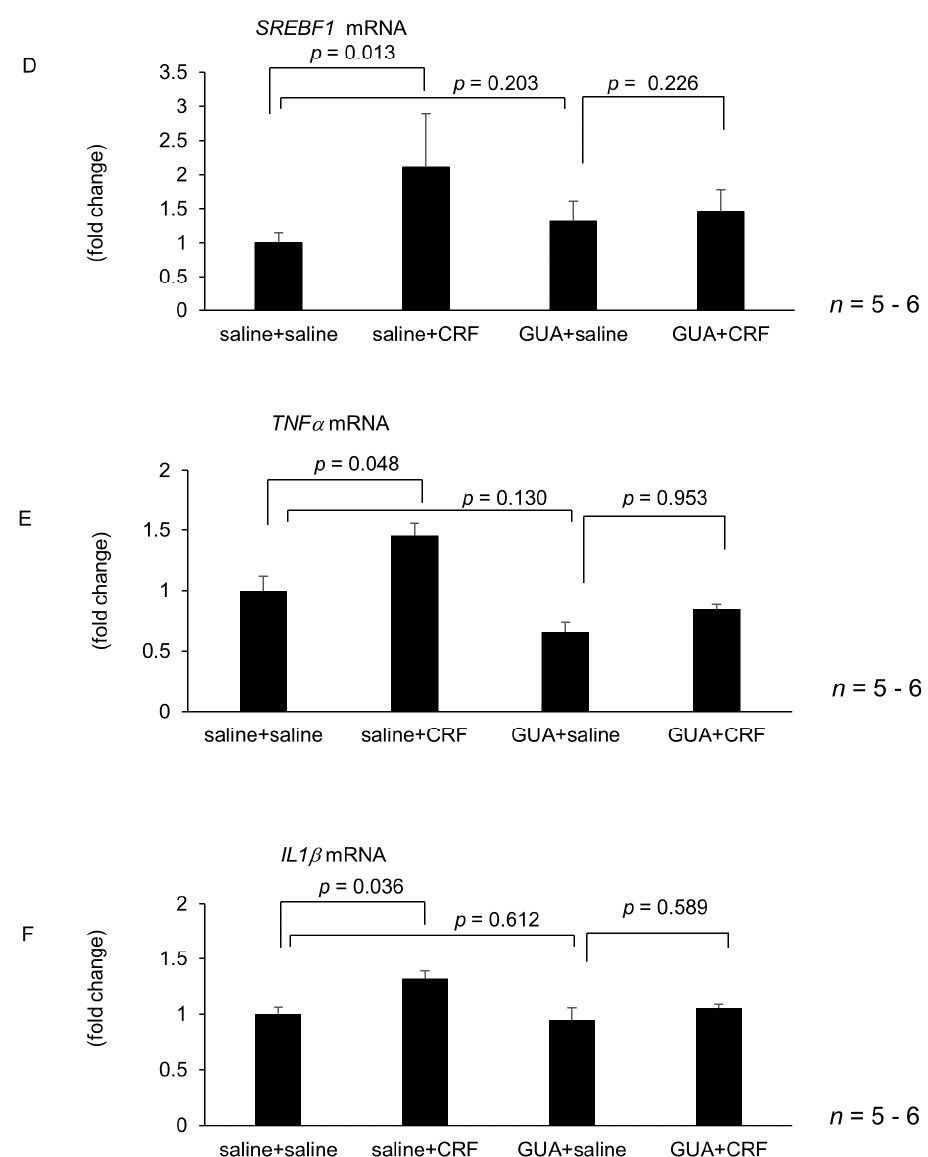
Figure 4. Effect of atropine (ATR) or guanethidine (GUA) on intracisternal CRF-mediated hepatic gene expression. The number of each group in rats was six. Hepatic lipid metabolism and inflammation-related gene expression 6 h after intracisternal CRF administration. Relative mRNA expressions of SREBF1 , TNF α , and IL1 β mediated by ATR ( A – C ) were evaluated and compared with respective saline control. Relative mRNA expressions of SREBF1 , TNF α , and IL1 β mediated by GUA ( D – F ) were evaluated and compared with respective saline control. Statistical analysis was performed using ANOVA, and data are expressed as means ± standard error (SE). ATR, atropine; GUA, guanethidine.